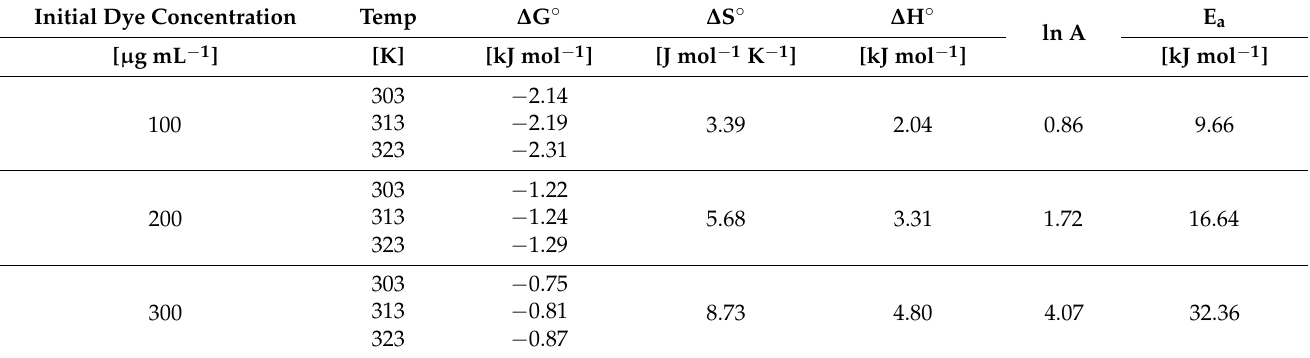
Table 7. Impact of temperature and beginning color focus on thermodynamic